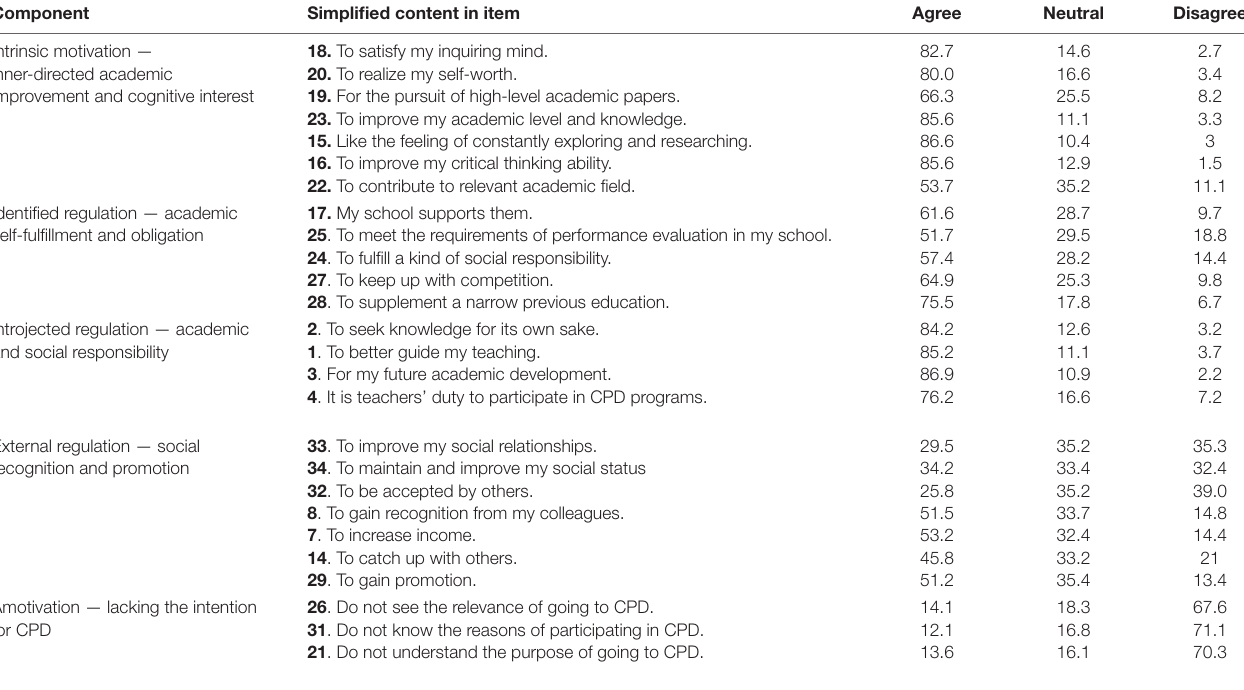
TABLE 4 | Frequency of responses to CPD motivation